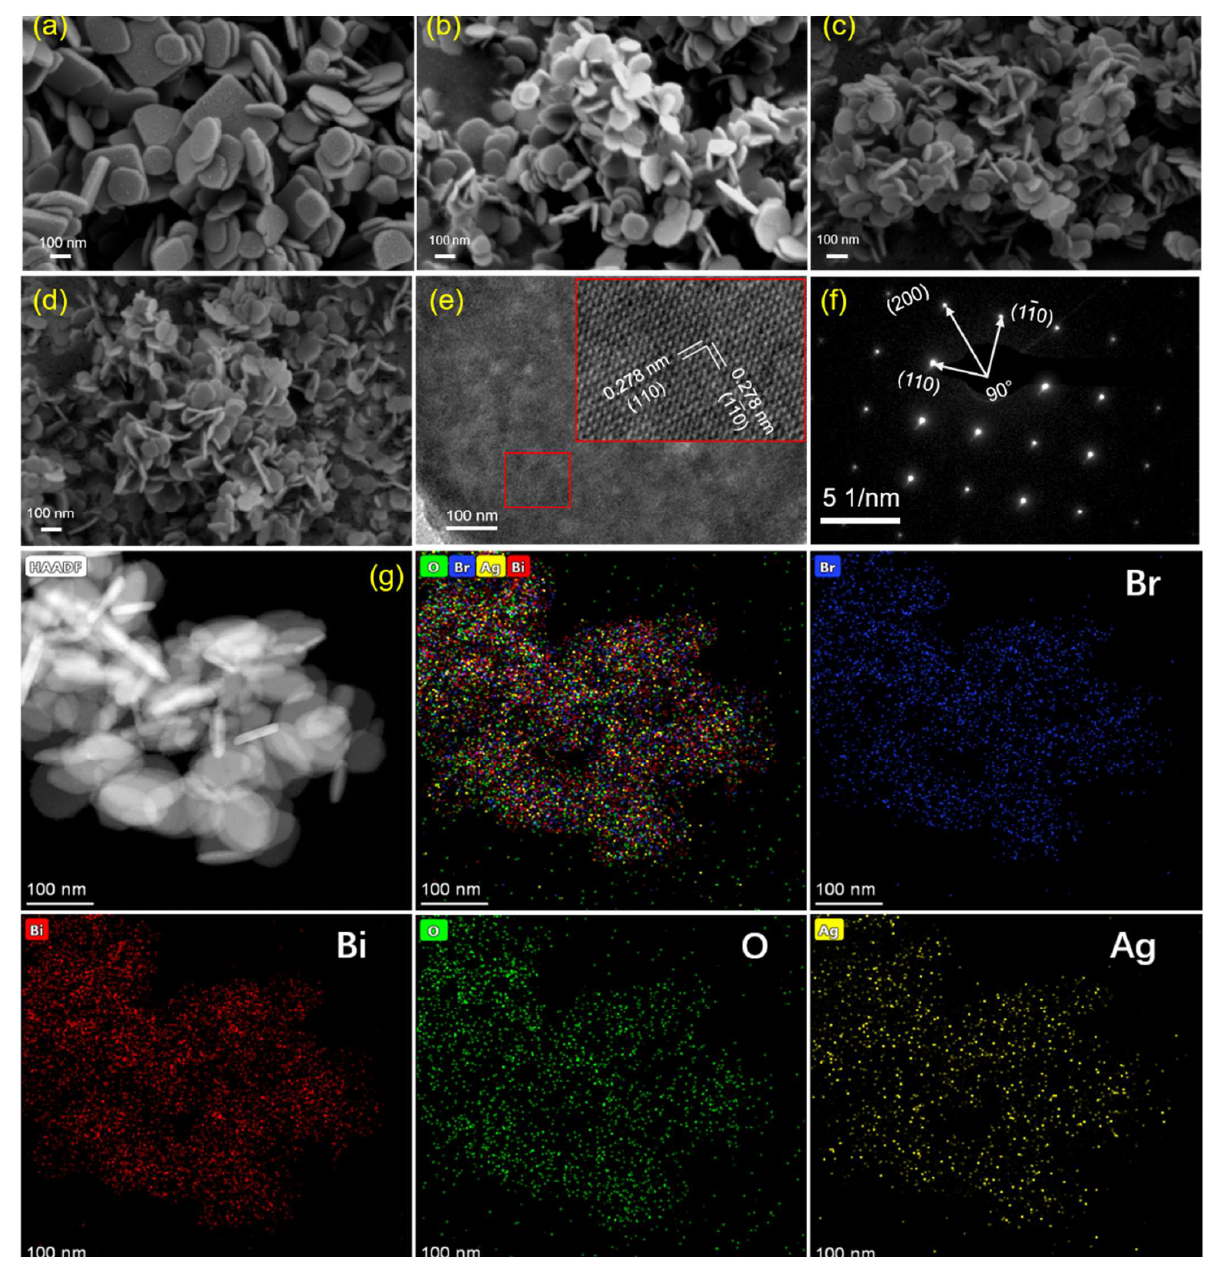
Figure 2. SEM of ( a ) BiOBr, ( b ) Ag 0.05 -BiOBr, ( c ) Ag 0.1 -BiOBr, ( d ) Ag 0.2 -BiOBr, ( e ) HRTEM, ( f ) SAED, ( g ) STEM and corresponding EDS mapping images of Ag 0.1 -BiOBr.